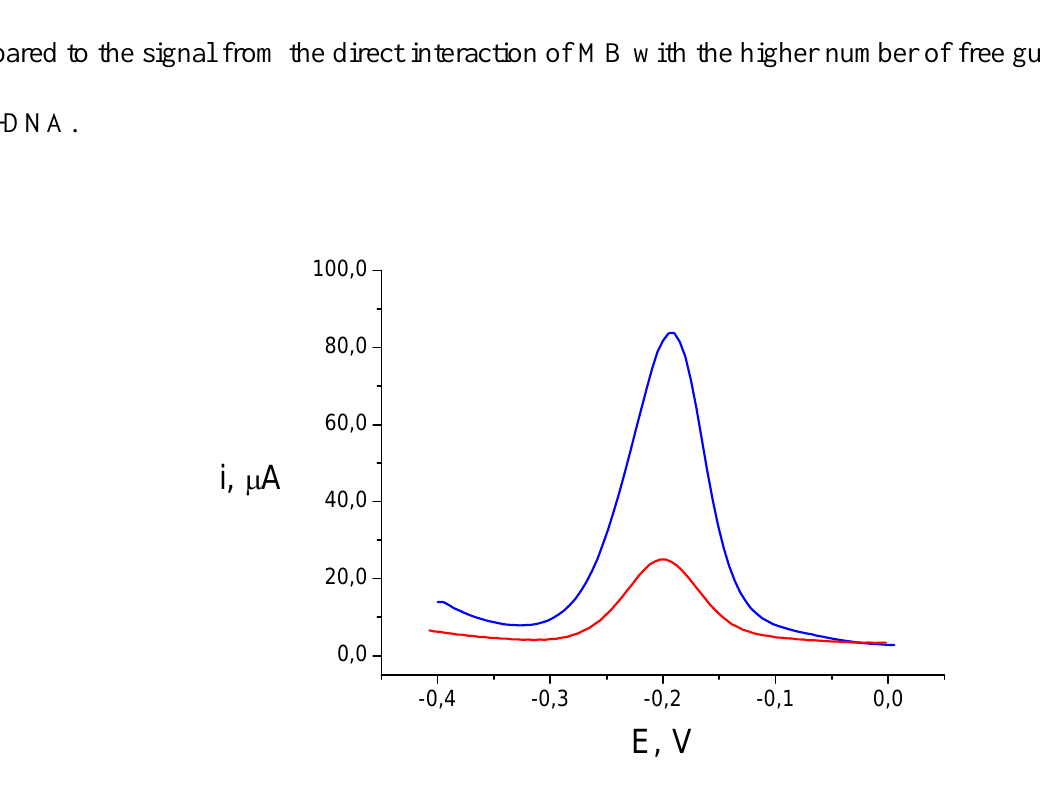
Figure 5. Stripping voltammograms obtained with the ss-DNA-EDC/NHSS-MPA-AuE ( ⎯ ) and with the ds-DNA-EDC/NHSS-MPA-AuE ( ⎯ ) after accumulation of MB. Supporting electrolyte: 50 mM Tris-HCl, 20 mM NaCl (pH 7.2). Immobilization conditions: 2.5 µg DNA, 24 h drying time. = 1 min, open circuit. Measurement conditions: SWV, Accumulation conditions: [MB] = 75 µ M, t acc = 30 mV, f = 100 Hz, v = 500 mV s -1 E sw